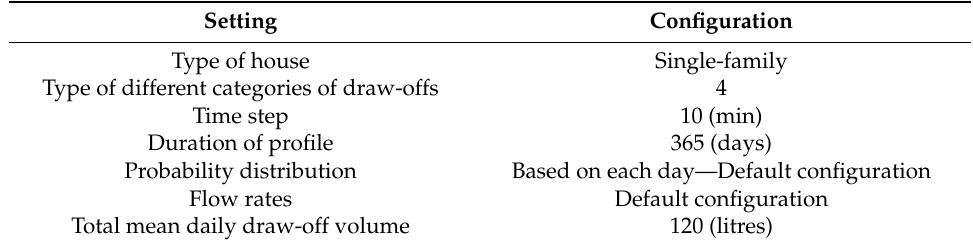
Table 2. Settings used in the DHW-calc program for calculating domestic hot water (DHW)